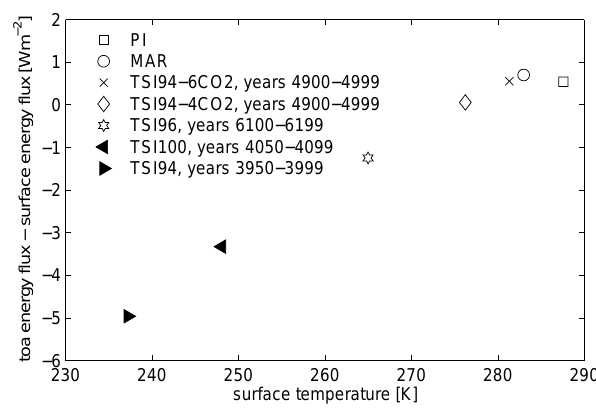
Fig. A1. Difference between the top of atmosphere energy flux and the surface energy flux in dependence of global-mean surface tem- perature. Positive values suggest the existence of an artificial en- ergy sink in the atmosphere model, negative values the existence of an artificial energy